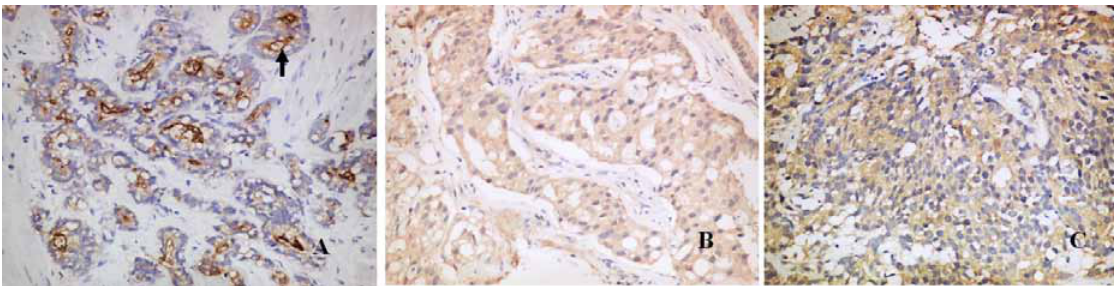
Figure 2. CEACAM5 is expressed with membranous pattern in well differentiated PCa(A), with cytoplasmic staining in moderately(B) and poorly differentiated PCa(C). 400×